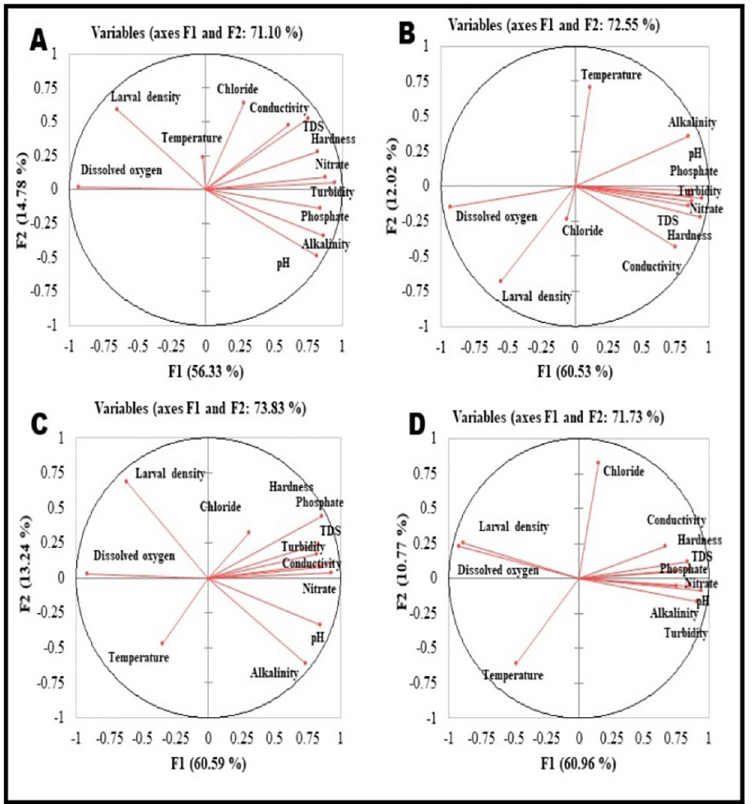
Fig 6. Principal component analysis showing the relationship between the physicochemical parameters of water and the larval density of Anopheles subpictus (A = summer, B = monsoon, C = post-monsoon, D = winter).